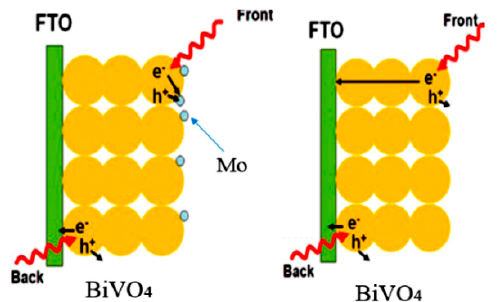
Figure 20. Transfer of photogenerated electrons in Mo-doped BiVO 4 photoelectrodes illuminated from the front-side and the back-side. Reprinted with permission from ref. [72]. Copyright 2018. American Chemical Society.